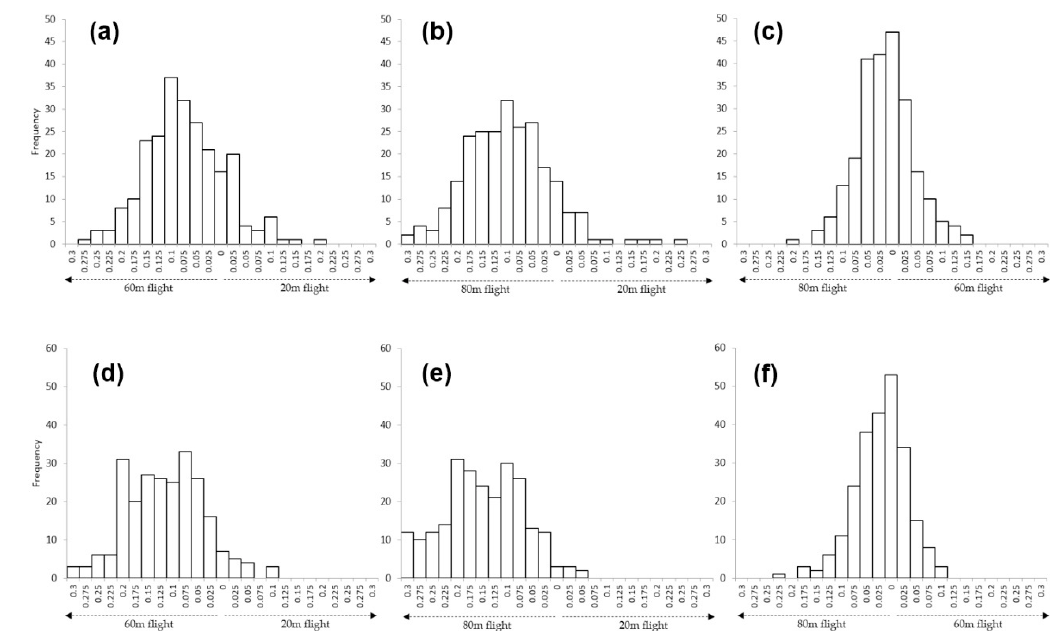
Figure 15. Histogram of di ff erence for NDVI and NDRE between di ff erent flight altitudes: ( a , d ) between 60 m and 20 m, ( b , e ) between 80 m and 20 m, and ( c , f ) between 80 m and 60 m.